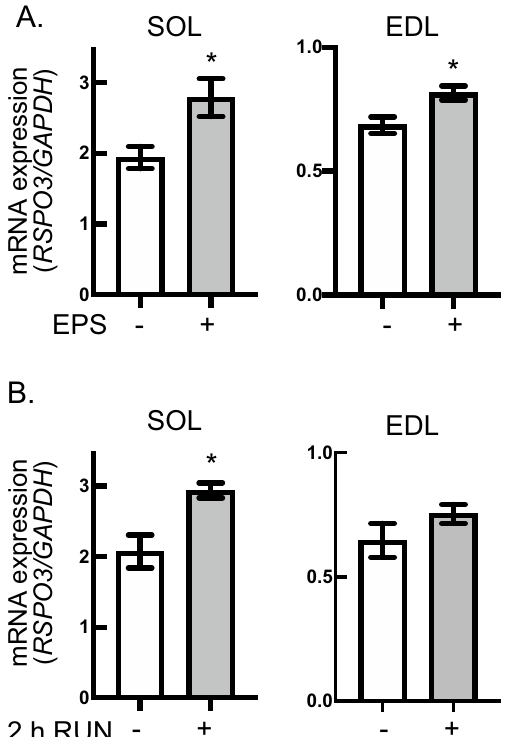
Figure 7. Mouse R-spondin 3 (RSPO3) upregulation upon contraction of in vivo skeletal muscles from mice. ( A ) After the in situ muscle contraction via sciatic nerve-mediated EPS treatment as described in the Methods, soleus (SOL) and extensor digitorum longus (EDL) muscles were obtained and subjected to RT-PCR analysis to evaluate mRNA levels for RSPO3. Data were normalized using mouse GAPDH transcripts and compared to those of the muscle tissues obtained from sham-operated control (opposite side) legs ( n = 9; * P < 0.05). ( B ) After 2 h of running (a running speed of ~ 12 m/min), SOL and EDL muscles were obtained and subjected to RT-PCR analysis. Data were normalized using mouse GAPDH transcripts and compared to those of the muscle tissues obtained from sedentary control mice ( n = 5 each; * P <